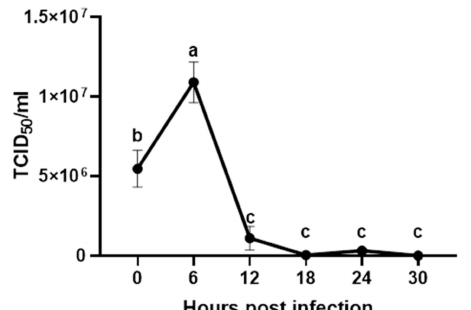
Figure 1. Replication kinetics of low pathogenic H9N2 AIV in chicken cecal tonsils (CT) mononuclear cells. CT mononuclear cells from specific-pathogen-free chickens ( n = 8 biological replicates) were infected with low pathogenic avian influenza virus H9N2 at an MOI of one. After one hour, CT mononuclear cells were washed and cultured in complete RPMI 1640 medium supplemented with 2 µ g / mL of TPCK-trypsin and then incubated for 30 h at 41 ◦ C at 5% CO 2 . PBS was used as negative control. Cell supernatants were collected at zero, six, 12, 18, 24, and 30 h post-infection, and viral titers were determined using MDCK cells. Virus titers are represented as 50% tissue culture infectious dose (TCID 50 / mL). Error bars represent standard errors of the mean, and di ff erent letters denote significant di ff erences between time points ( p < 0.05).